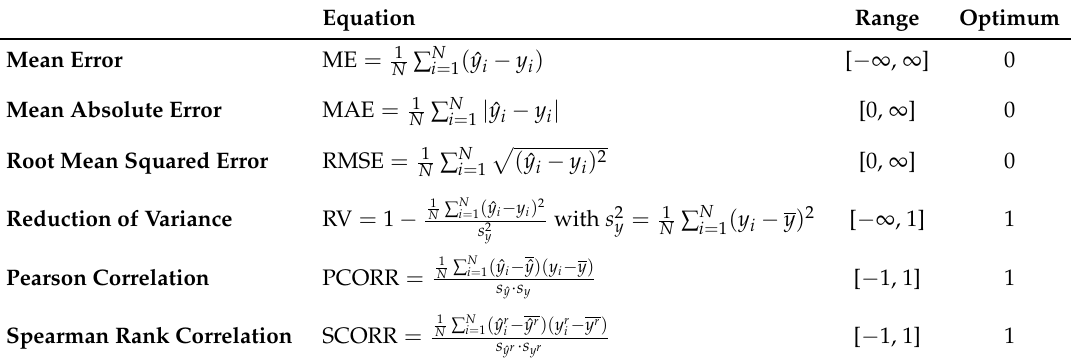
Table 6. The regression scores equation, value range and optimum value. y i is an observation and ˆ y i is its estimation. The Spearman rank correlation is the Pearson correlation of the rank of the observations and the